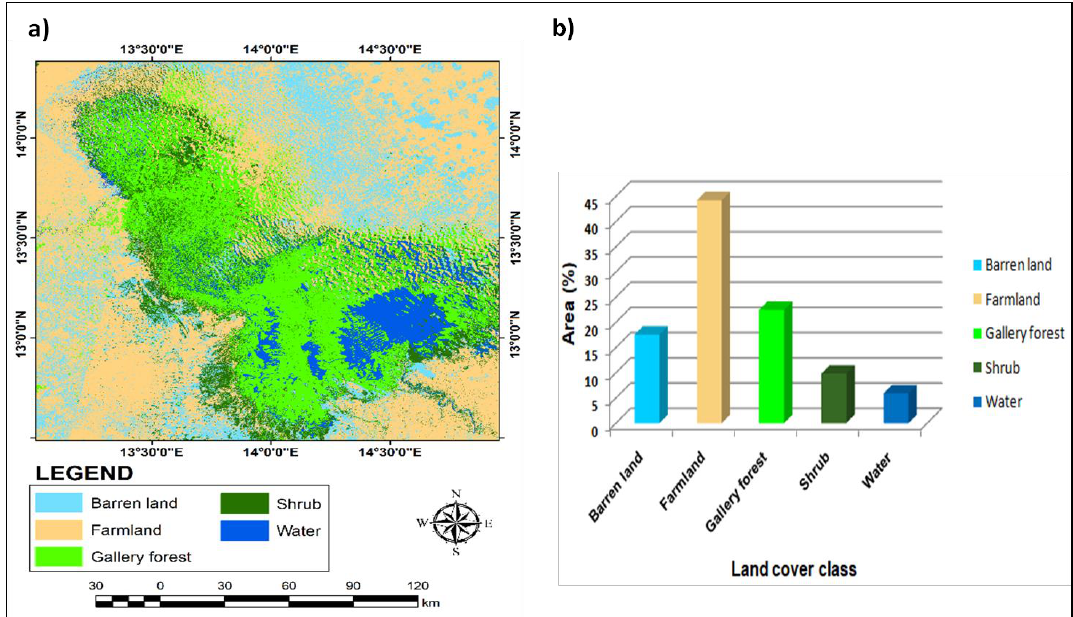
Figure 5. (a) Lake Chad change map in 2015, (b) area coverage percentage for each class